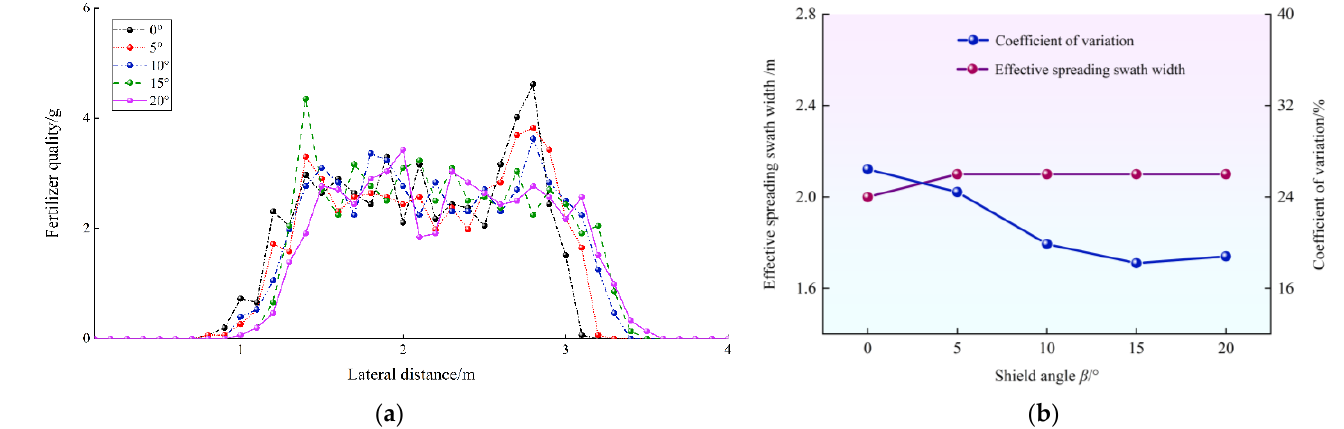
Figure 11. Effects of the shield angle β . ( a ) Fertilizer quality distribution along the lateral distance; ( b ) variations of effective swath width.